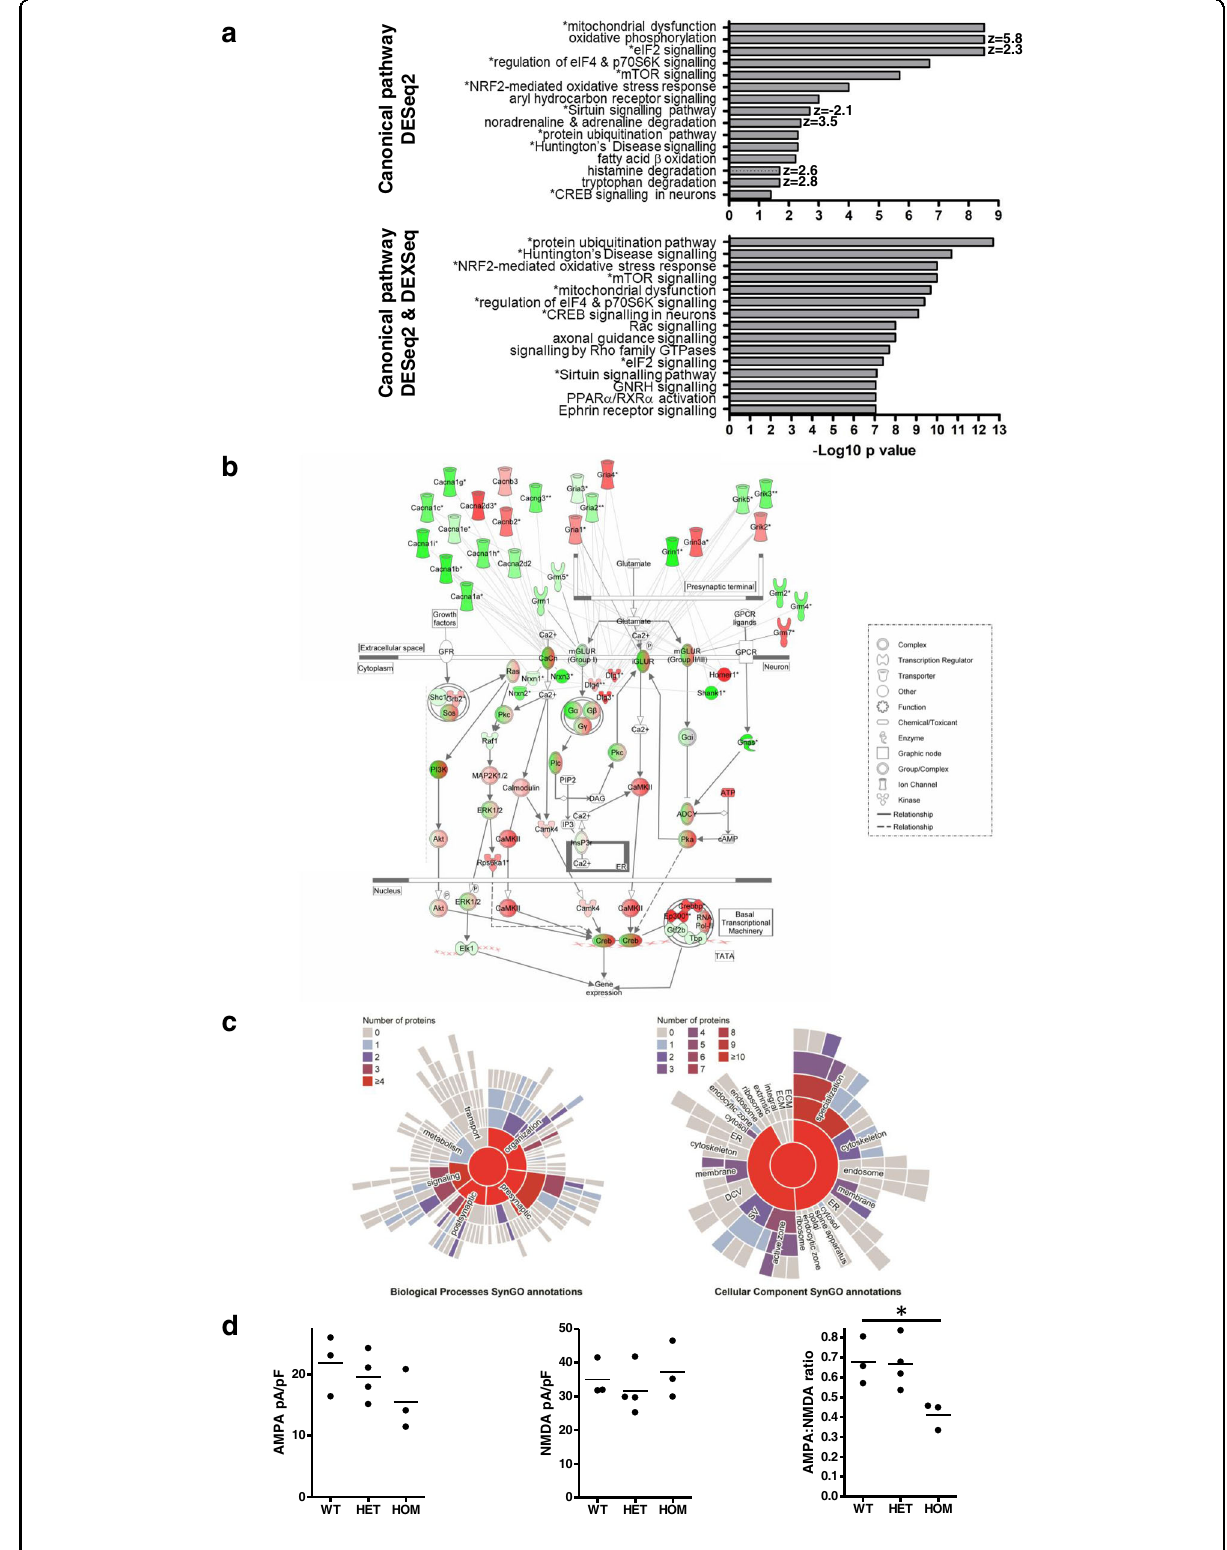
Fig. 2 (See legend on next